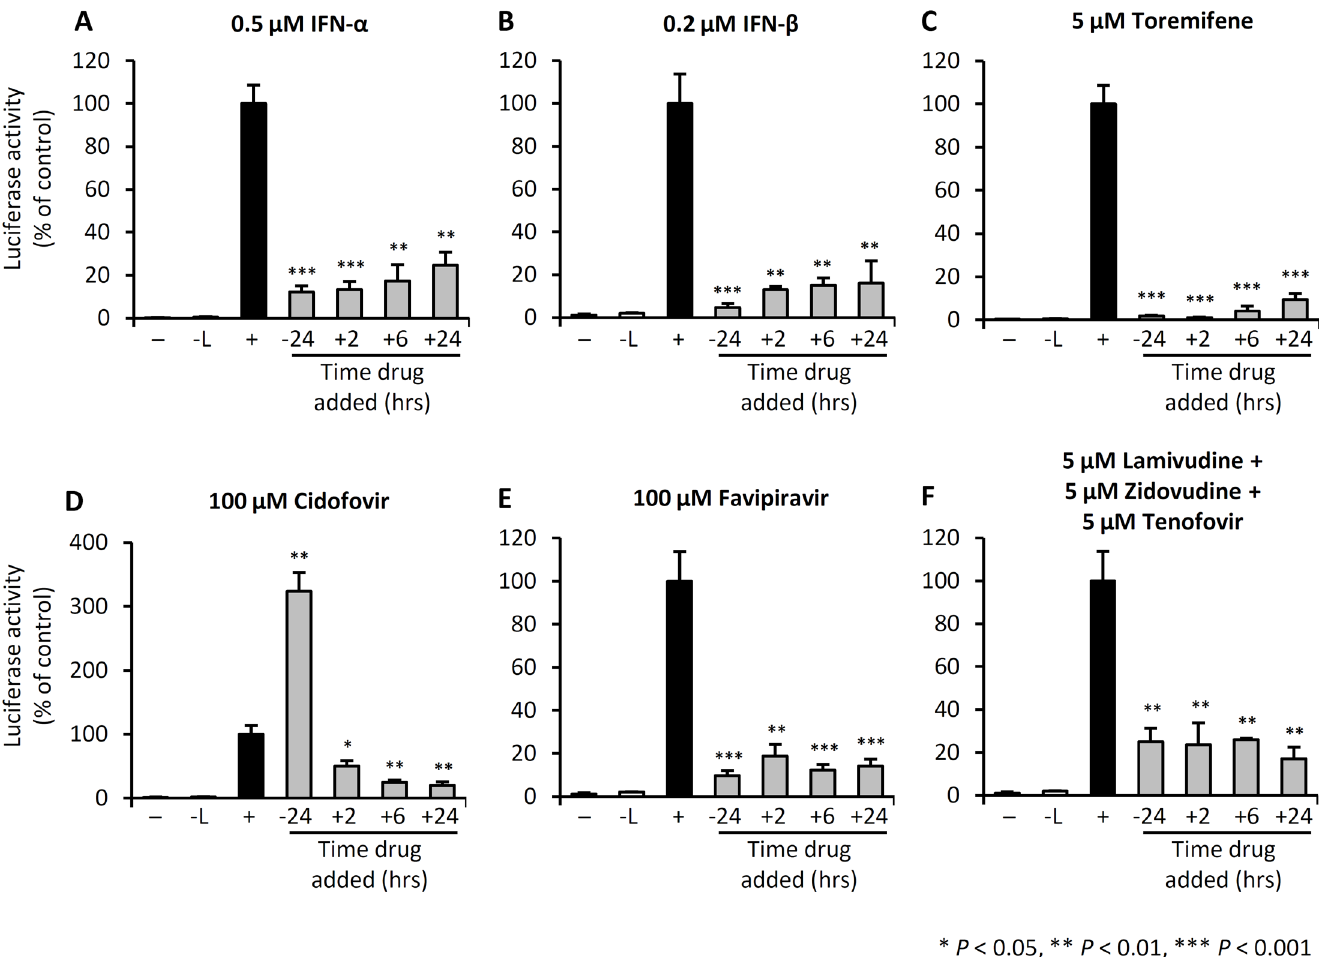
Fig 1. IFNs, toremifene, and nucleoside analogs inhibit trVLP replication. 293 T cells were either left untreated (-), transfected with the mini-genome and the nucleocapsid plasmids NP, VP30, VP35 and T7 (-L), or transfected with the mini-genome and all expression plasmids to permit Ebola mini-genome entry and replication (+). (A-F) Cells were treated with the indicated drugs at the indicated doses, at each of the time points shown. Luciferase activity was measured 4 days post-trVLP infection. Values shown are the means of 4 biological replicates and are representative of 2 independent experiments. Error bars are the standard error of the mean. All drug treatment outcomes were statistically compared with the (+) control group. See also S1 Fig.